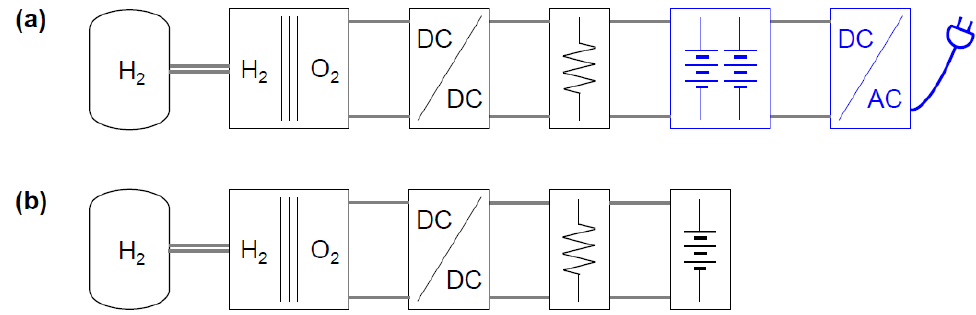
Figure 3. Comparison of hybrid structures. ( a ) Plug-in HPS versus ( b ) HPS.